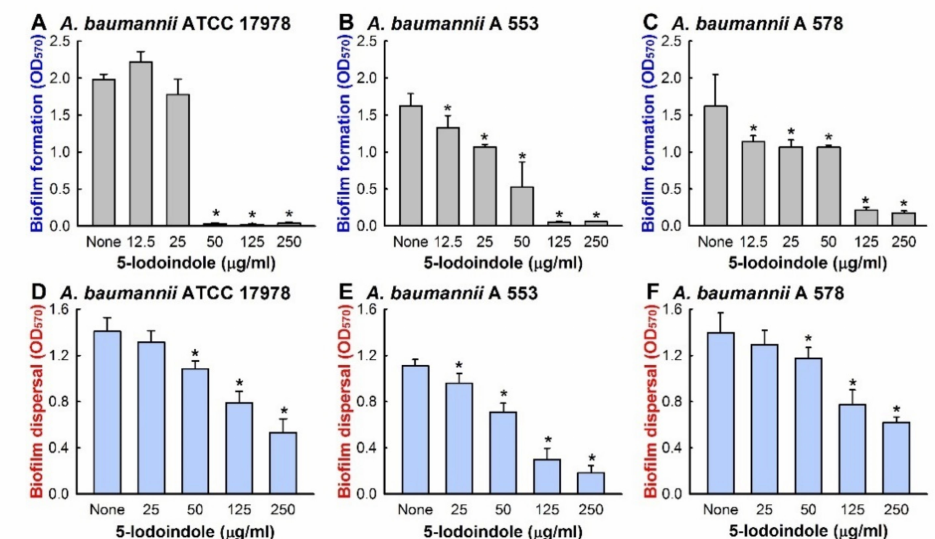
Figure 1. Biofilm inhibition and dispersal of A. baumannii by 5-iodoindole. Biofilm inhibitory e ff ects